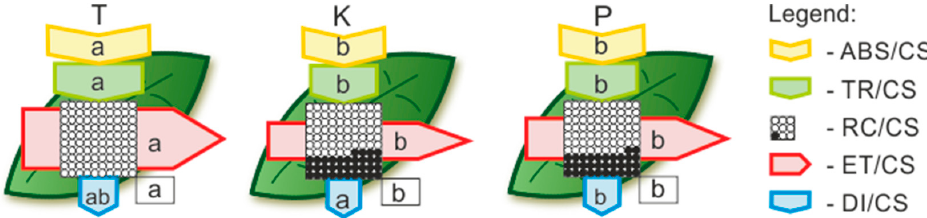
Figure 4. Leaf model showing the phenomenological energy fluxes per the excited cross sections (CS) of the leaves of the B. pendula growing on the reference site (T), post-coal mine heap (K), and post-smelter heap (P). Each relative value of the measured parameters is the mean (n = 10) and the width of each arrow corresponds to the intensity of the flux. Yellow arrow—ABS/CS, absorption flux per CS (approximated); green arrow—TR/CS, trapped energy flux per CS; red arrow—ET/CS, electron transport flux per CS; blue arrow—DI/CS, dissipated energy flux per CS; circles inscribed in squares—RC/CS, % of active/inactive reaction centres. White circles inscribed in squares represent reduced Q A reaction centres (active), black circles represent non-reduced Q A reaction centres (inactive); 100% of the active reaction centres responded with the highest mean value observed in the control conditions. Means followed by the same letter for each parameter in a row are not significantly different from each other according to the Tukey HSD test ( p < 0.05). Letters are inscribed into arrows, except for RC/CS, where they are placed in a box in the bottom right corner of the square with circles. Abbreviations: T—reference population from Tychy; K—birch population from